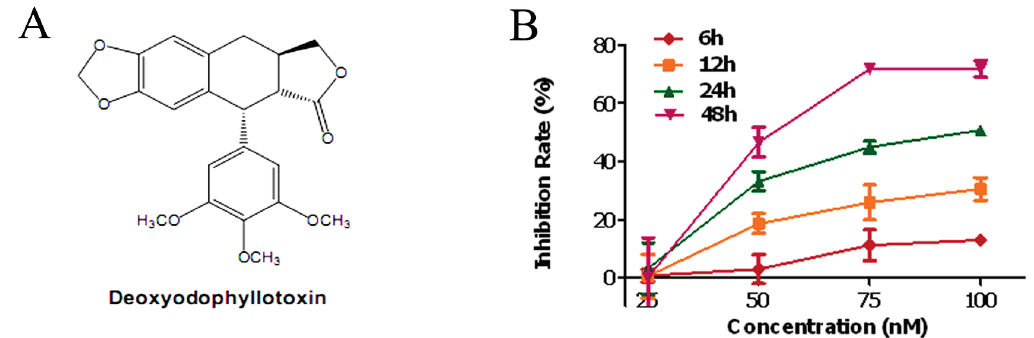
Figure 1. Antiproliferative activity of deoxypodophyllotoxin (DPT). ( A ) Chemical structure of DPT. ( B ) SGC-7901 cells were treated with different concentrations of DPT (25–100 nM) for the indicated time periods. Cell proliferation was then measured using a Cell Counting Kit-8. Data are presented as means ± SD of three independent experiments.